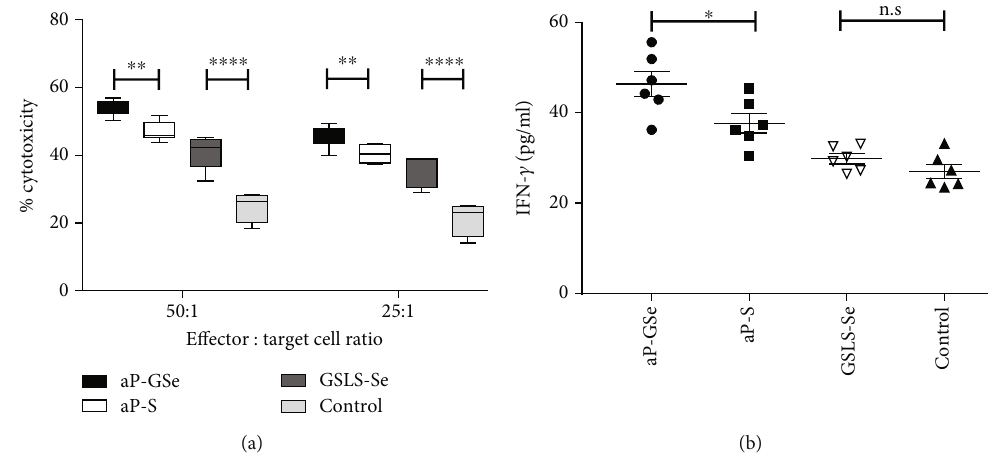
Figure 8: Cytotoxicity of NK cells (a) and IFN- γ response (b). Mice ( n = 6 /group) received i.m. injection of aP-GSe or aP-S, or just injection of saline with or without GSLS-Se. In twenty-four-hour postimmunization, splenocytes were isolated for analysis of cytolytic activity to YAC-1 cells by an MTT method, and blood samples were collected for analysis of IFN- γ by an ELISA. Data are expressed as the min to max (a) or mean ± SE (b). ∗ p < 0 : 05 , ∗∗ p < 0 : 01 , ∗∗∗∗ p < 0 : 0001 vs. aP-S group or control as indicated by two-way ANOVA with Tukey ’ s multiple comparisons test (a) or one-way ANOVA with LSD test (b).